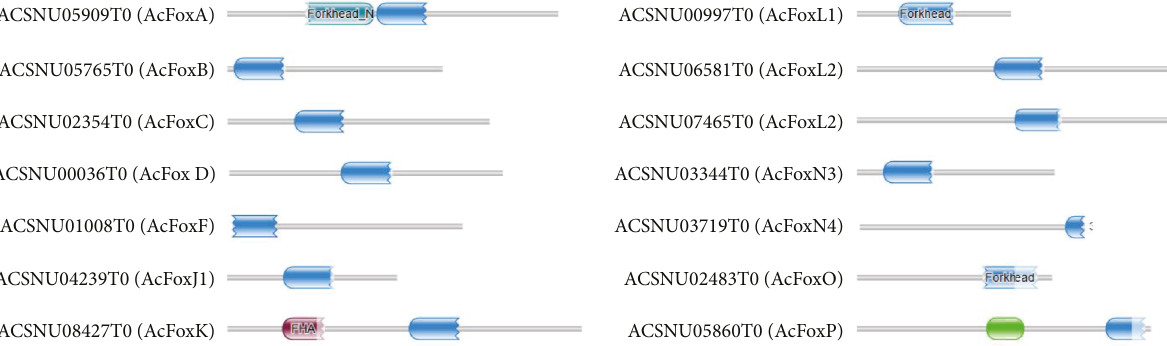
Figure 3: Domains of the Fox proteins in A. cerana . Conserved domains of the AcFox protein: dark cyan, forkhead N-terminal region; blue, forkhead domain; purple, FHA domain; green, FOXP coiled-coil